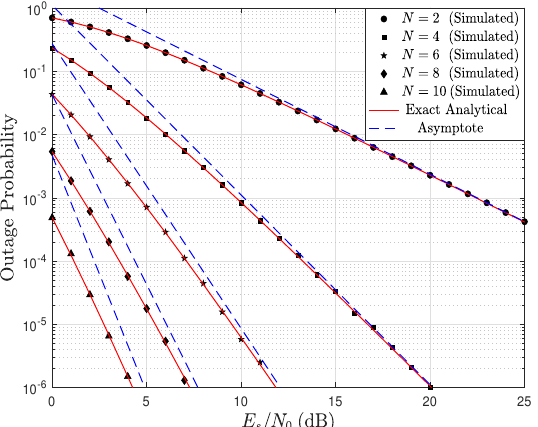
Figure 3. OP as a function of E s / N 0 , parameterized by N = N r = N d , and considering k r = k d = 1.5, and λ r = λ d = 1.